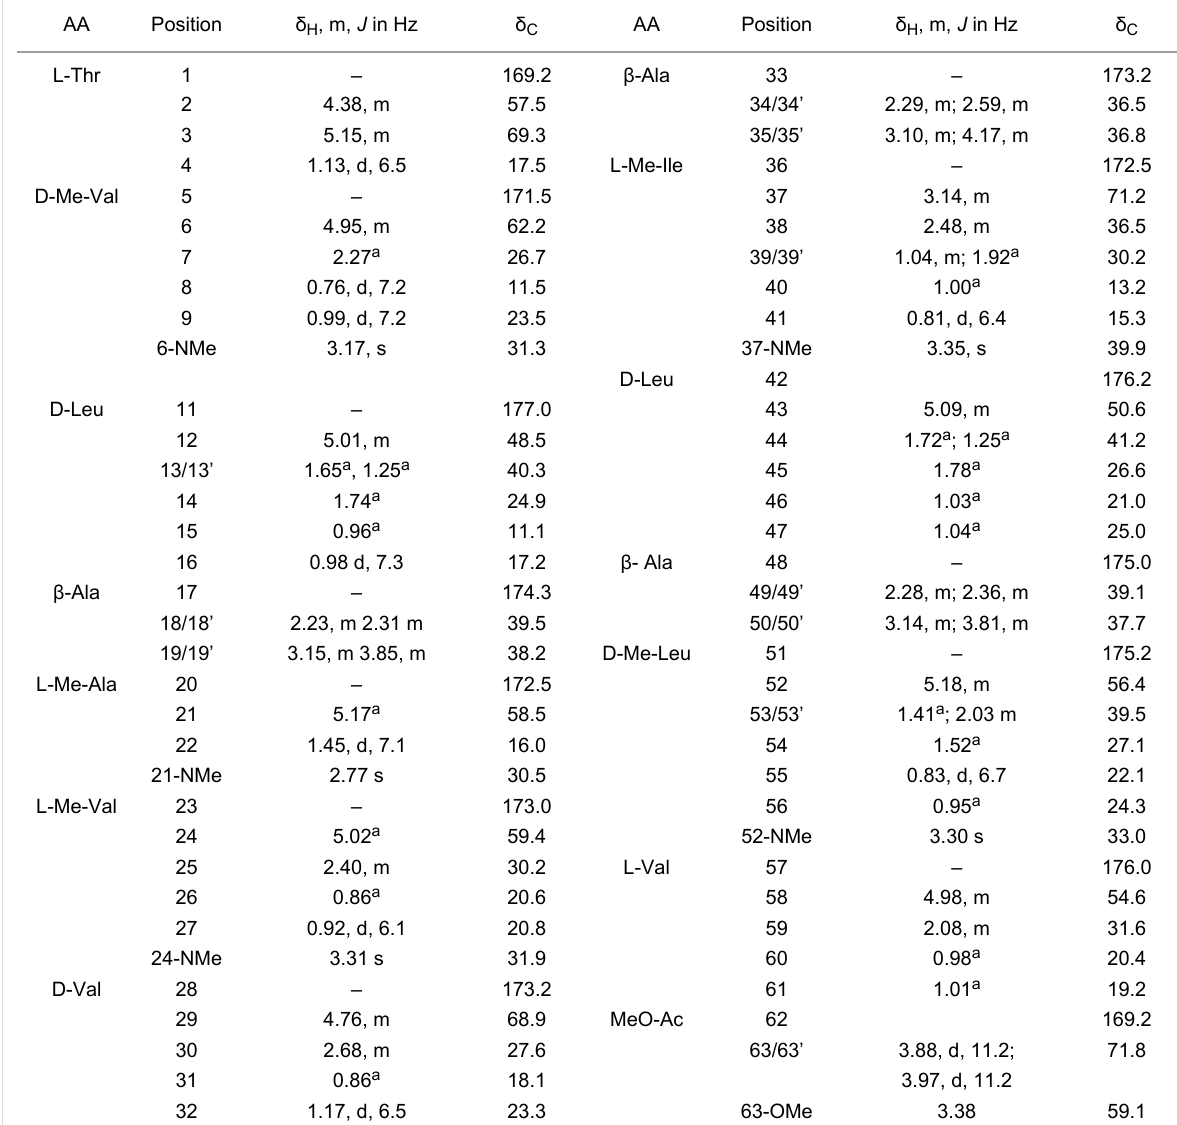
Table 2: 1 H (500 MHz) and 13 C (125 MHz) NMR data of theonellapeptolide If ( 3 ) in CD 3 OD